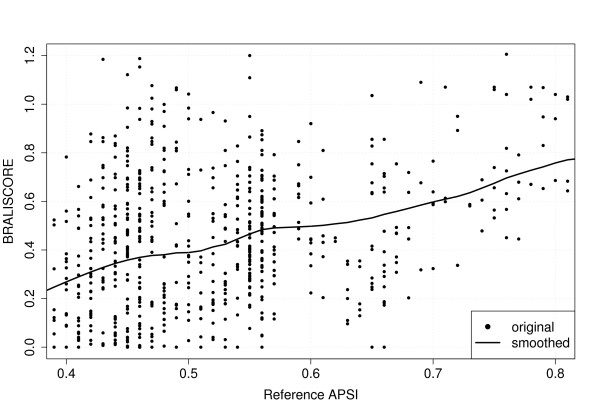
Lowess smoothing. The plot shows the scattered data points, each corresponding to one alignment, exemplified by the performance of PROALIGN with k = 7 sequences per alignment. The curve is the result of a lowess smoothing with a smoothing factor of 0.3.